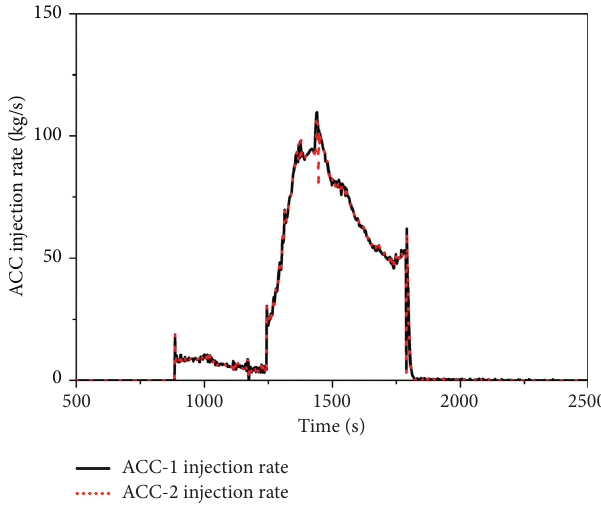
Figure 17: 2-inch CL break ACC injection mass flow